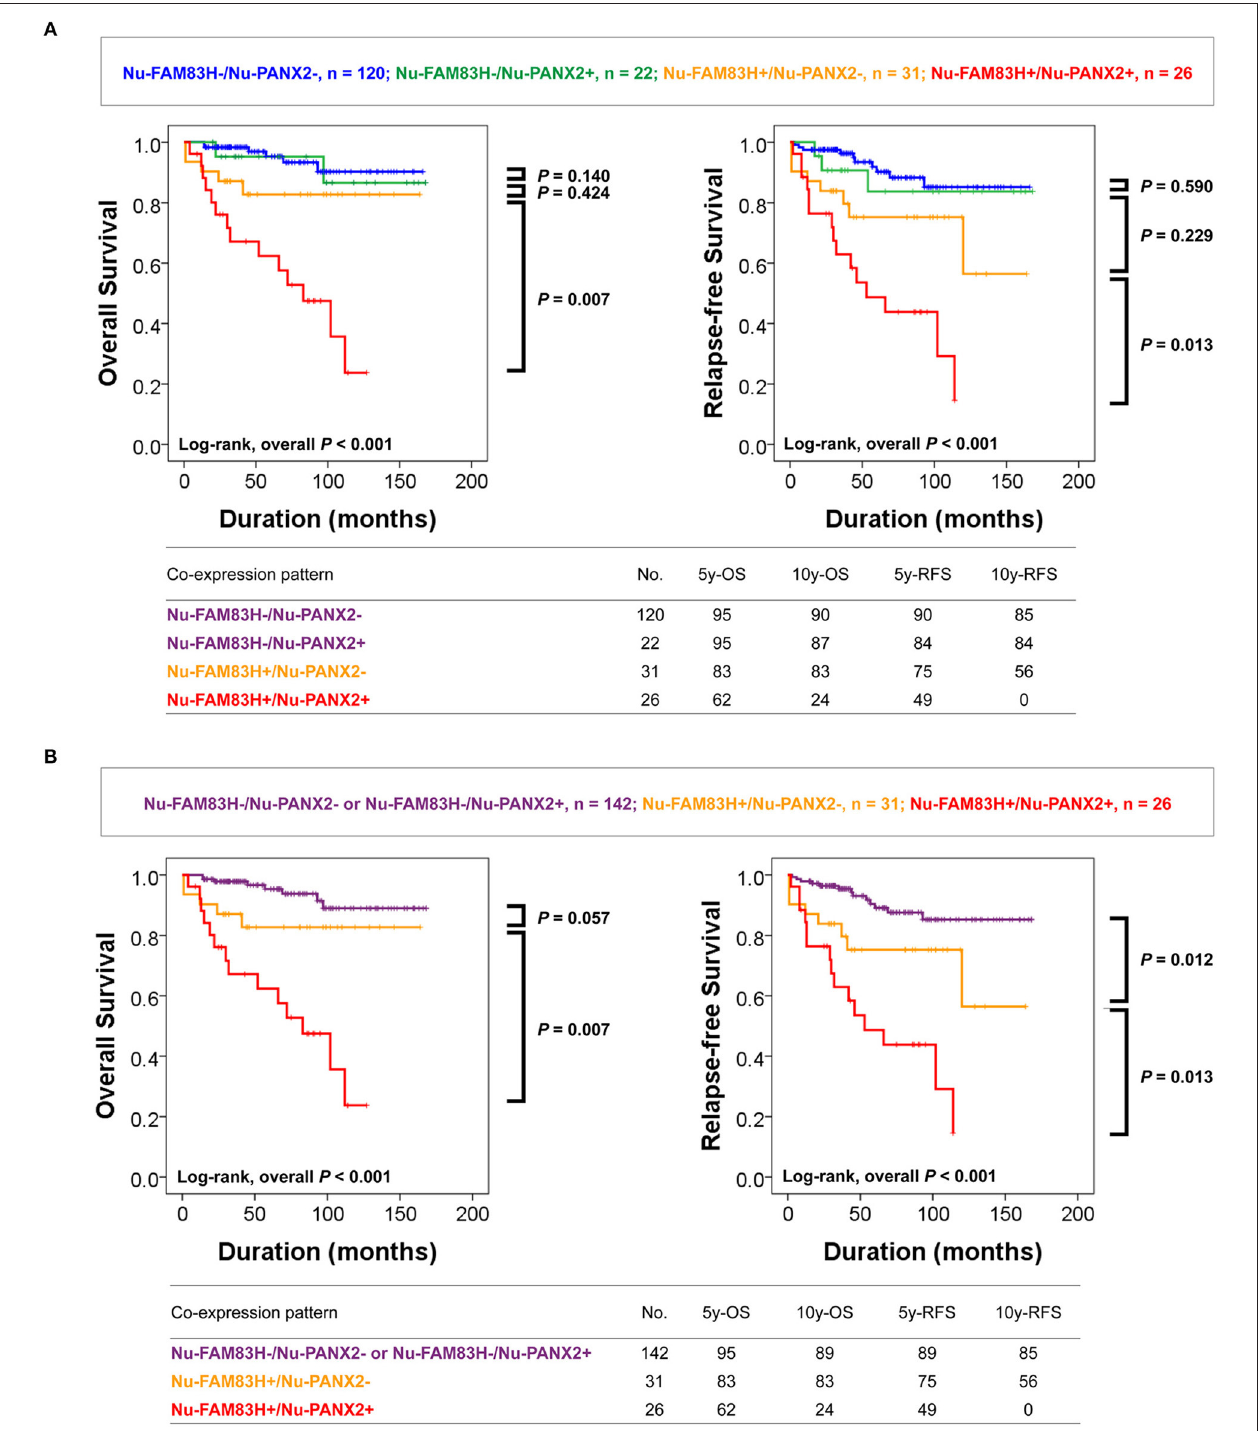
FIGURE 3 | Survival analysis according to the co-expression patterns of nuclear FAM83H and nuclear PANX2 expressions. (A) Kaplan-Meier survival analysis in Nu-FAM83H − /Nu-PANX2 − , Nu-FAM83H − /Nu-PANX2 + , Nu-FAM83H + /Nu-PANX2 − , and Nu-FAM83H + /Nu-PANX2 + subgroups according to the nuclear expression of FAM83H and PANX2. (B) Kaplan-Meier survival analysis in three subgroups according to the co-expression patterns of nuclear FAM83H and PANX2; favorable (Nu-FAM83H − /Nu-PANX2 − and Nu-FAM83H − /Nu-PANX2 + ), intermediate (Nu-FAM83H + /Nu-PANX2 − ), and poor prognostic (Nu-FAM83H + /Nu-PANX2 + ) subgroups. 5y-OS; five-year overall survival rate, 10y-OS; ten-year overall survival rate; 5y-RF; five-year relapse-free survival rate, 10y-RFS; ten-year relapse-free survival rate.